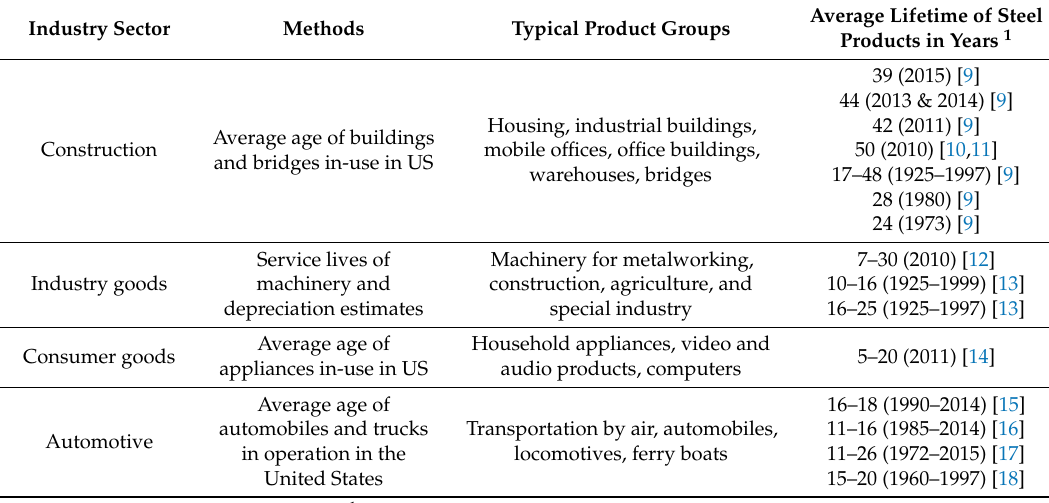
Table 1. Previously reported average lifetimes of steel by industry sector and product groups in the U.S. between 1925 and